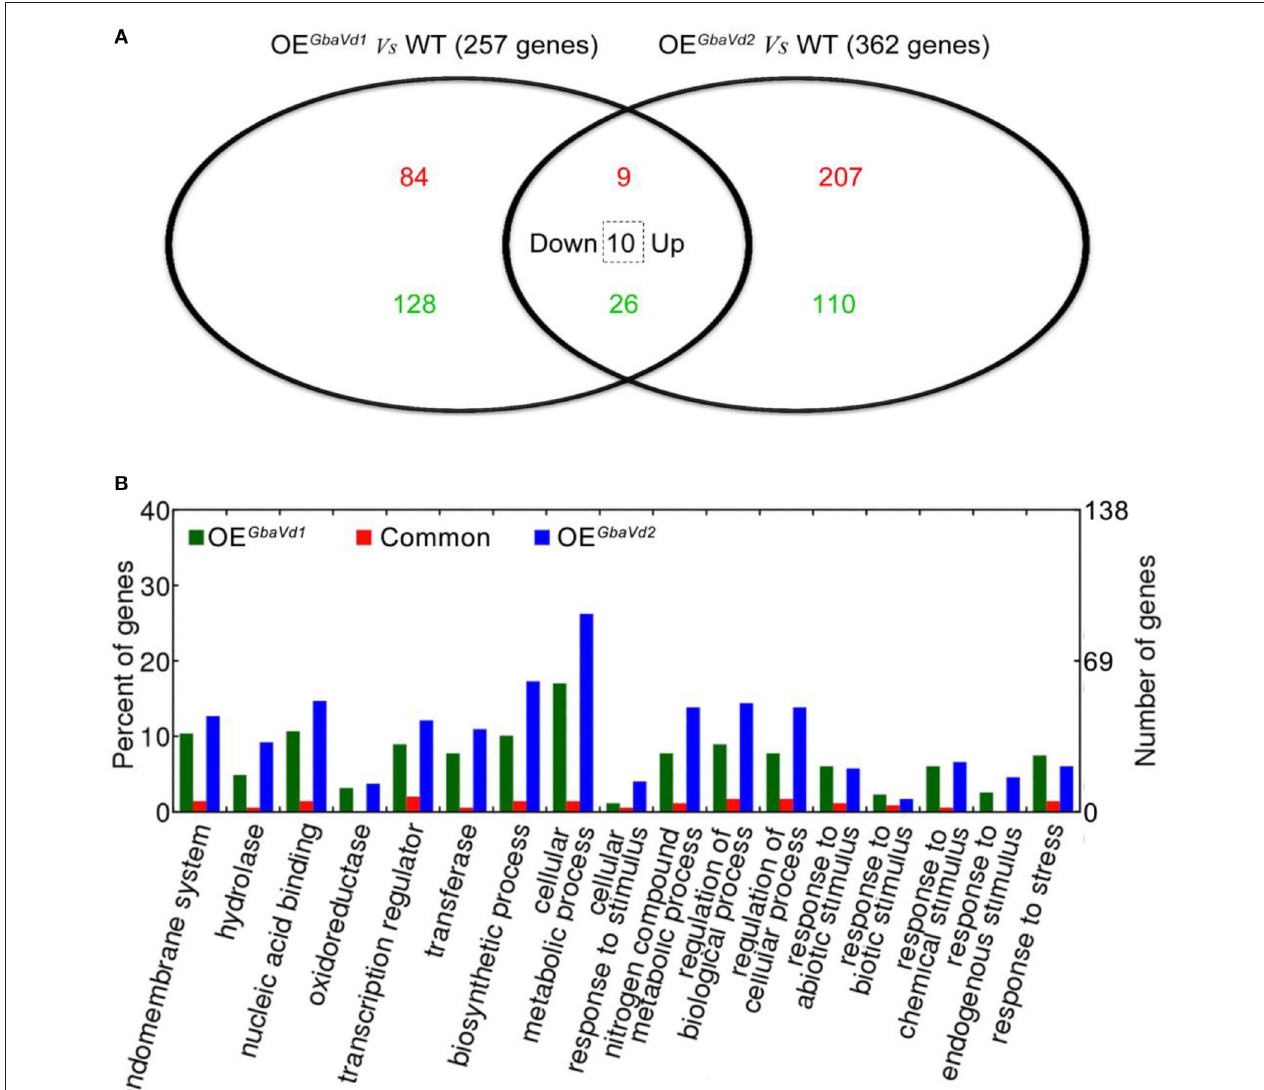
FIGURE 5 | Microarray analysis of differentially expressed genes in GbaVd1 and GbaVd2 transgenic lines. (A) The Venn diagram represents the differentially expressed genes between the transgenic and wild-type (WT) lines under normal conditions. The red numbers represent the up-regulated genes, the green numbers represent the down-regulated genes, and the number in the dotted box represents genes down-regulated in the GbaVd1 transgenic line but up-regulated in the GbaVd2 transgenic line. (B) GO analysis of differentially expressed genes in GbaVd1 and GbaVd2 transgenic